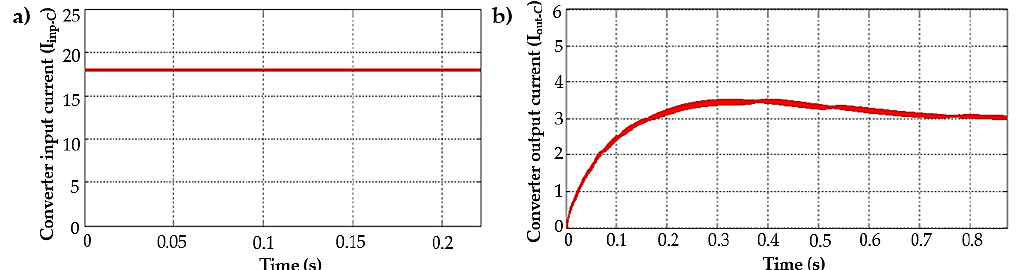
Figure 6. Current waveforms of the modified LUO converter using the GWO algorithm. ( a ) Converter input current; ( b ) Converter output current.